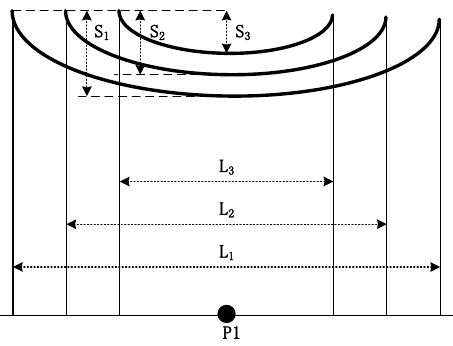
Figure 7. Effect of span length on cross-level electric field ( S 1 = S 2 = S 3 ).